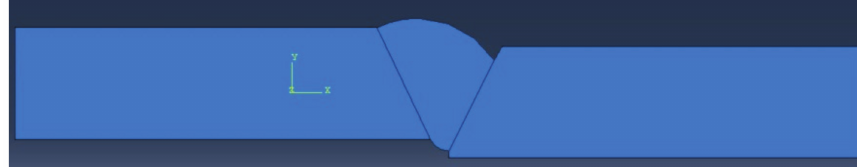
Figure 4. Model with vertical misalignment, incomplete root penetration, and undercut.